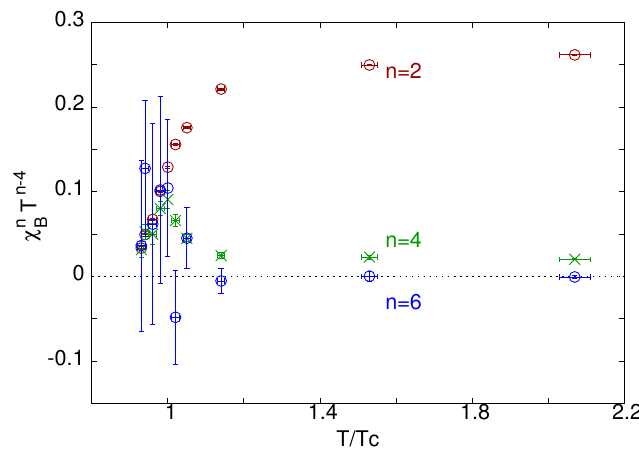
Figure 2. The baryon number susceptibilities of different order in the temperature range 0.9–2 T c